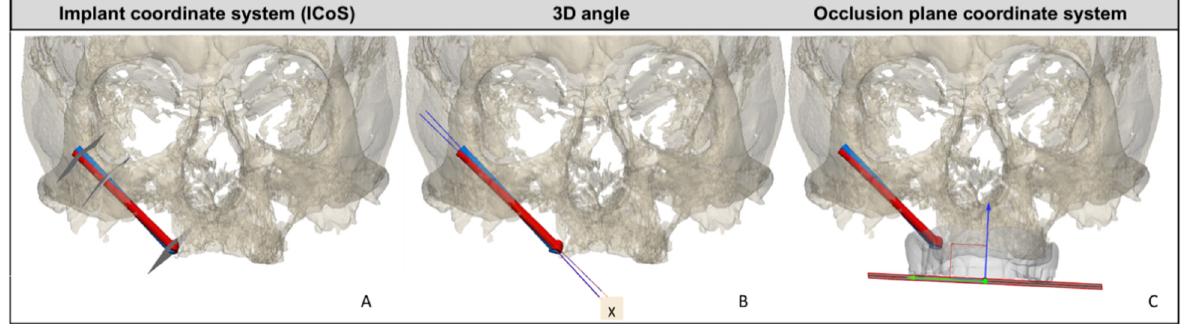
Figure 4. Overview of the different types of measurements and reference planes or coordinate systems for assessing the accuracy of zygomatic implant placement derived from post-op CBCT. In red, the planned zygomatic implant position; in blue, the postoperative zygomatic implant position. ( A ) The implant coordinate system (ICoS), including the three reproducible reference planes in which the accuracy is measured: the center of the zygomatic implant head, bone entry point of the implant, and bone exit point of the implant. ( B ) 3D angular deviation between 3D-planned position and postoperative implant position. X represents the 3D angle deviation. ( C ) Occlusion plane coordinate system. A plane parallel to the prosthetic occlusional plane is defined; perpendicular to this plane is the blue arrow. This arrow indicates the direction in which the abutment height accuracy is calculated. Deviation of the abutment is measured in the occlusional plane (green arrow).